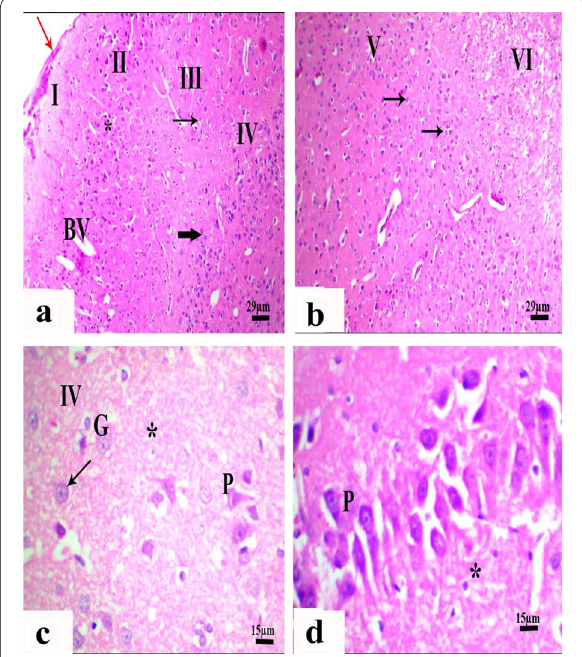
Fig. 2 photomicrographs of sections of the cerebral cortex obtained from ALA- treated rats showing a : cerebral cortex covered by pia matter (red arrow) and its gray matter with six layers the outer molecular layer (I), the external granular layer (II), the external pyramidal layer (III) contains pyramidal cell (thin arrow), the inner granular layer (IV) contain granule cells with open face nuclei (thick arrow), and blood vessel (BV) also seen. b : the inner pyramidal layer (V) contained pyramidal cell (arrows) and polymorphic layers (VI). c : the internal granular layer (IV) contains rounded granule cells (G) with open face nuclei (arrow), and few pyramidal cells (P) surrounded by normal neuropil (*). d : showing the internal pyramidal layer with large sized pyramidal cells (P), and normal neuropil